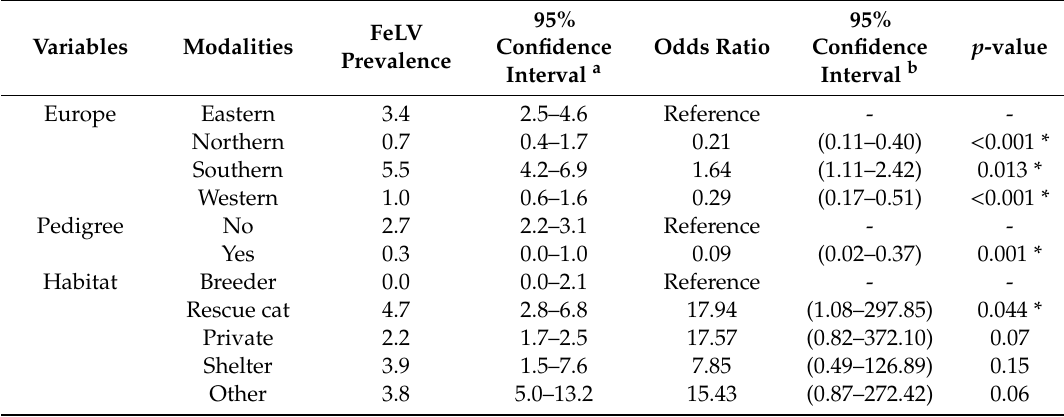
Figure 2. Age distribution of the cats: grey: FeLV-negative cats (left axis), black: FeLV-positive cats (right axis). Cats aged from one to six years were significantly more frequently FeLV-positive than younger or older cats ( p F < 0.0001; see also Table 3). Table 3. Risk and protective factors associated with positive FeLV viraemic status of cats after univariate logistic